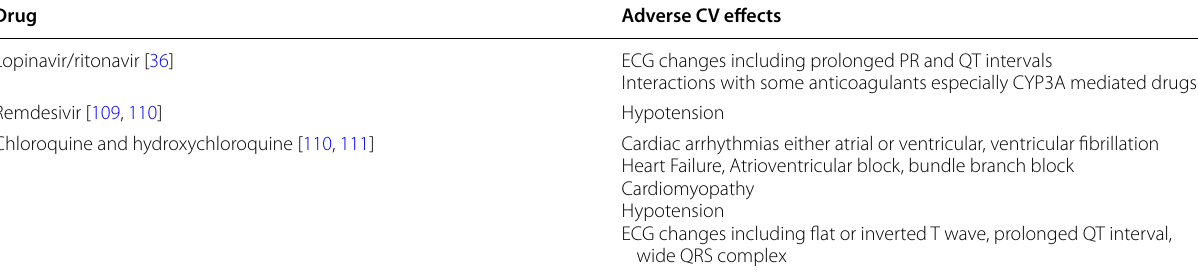
ECG: electrocardiogram